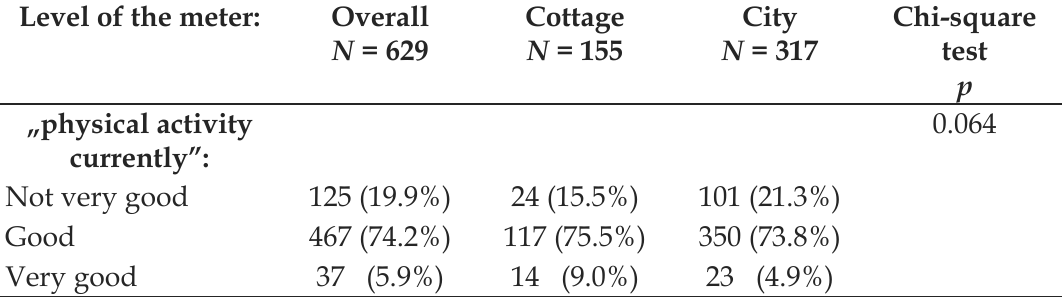
Basic statistics (numbers and proportions) of students differing in the level of SPM “physical activity currently” and place of residence.